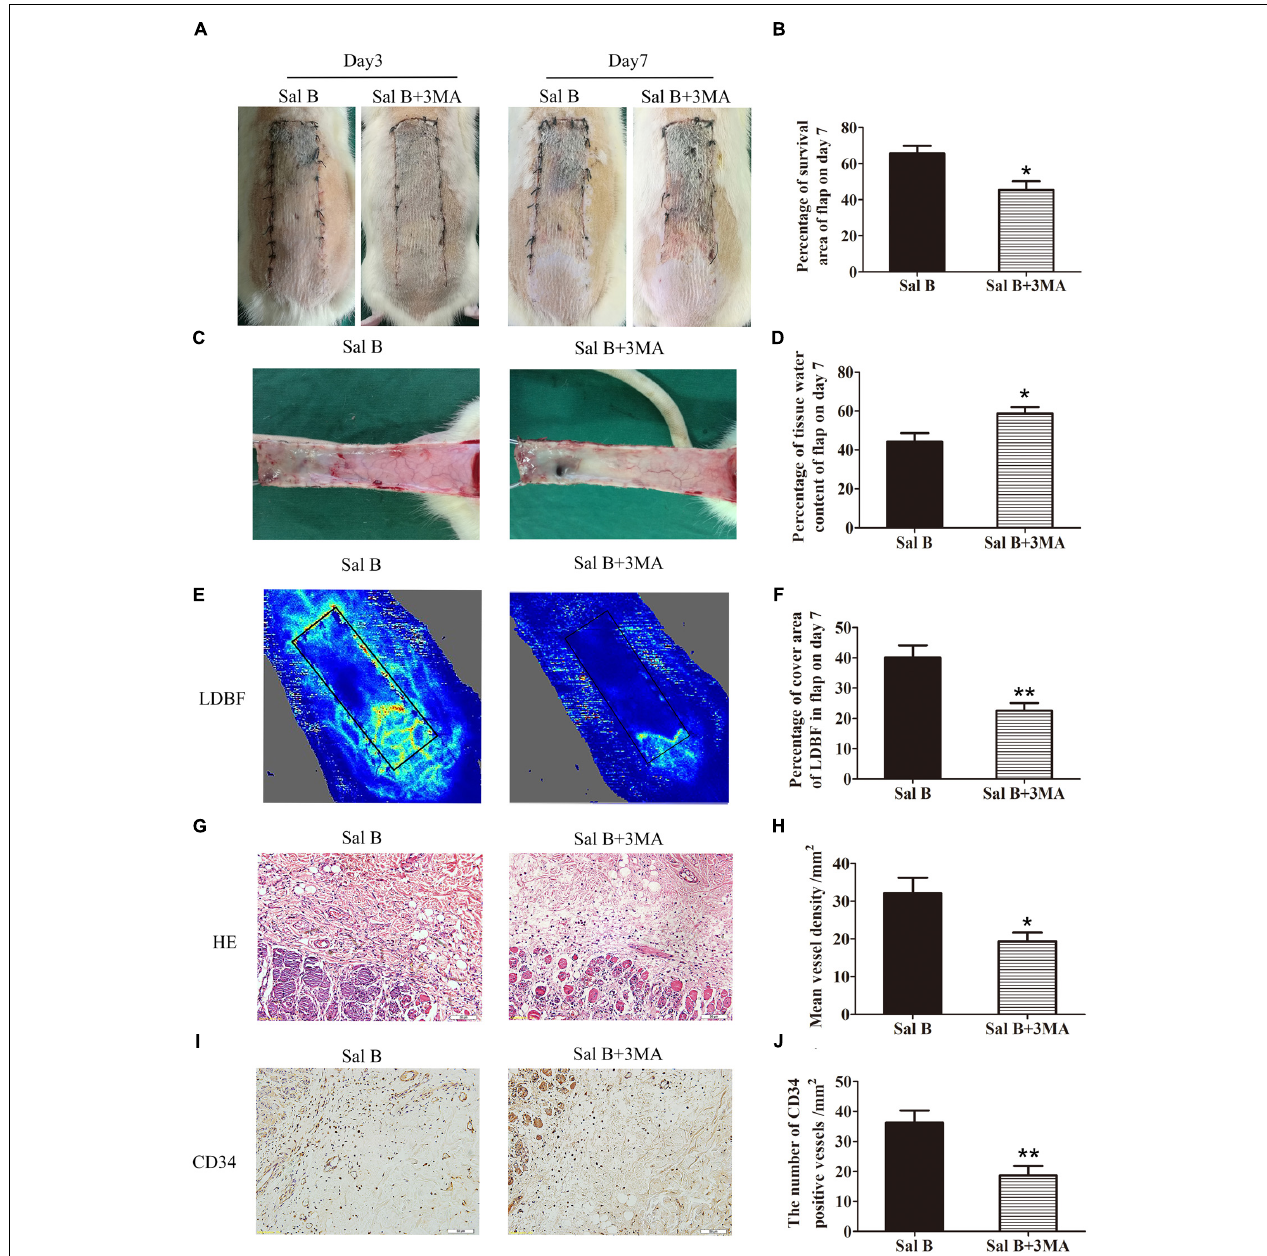
FIGURE 7 | Inhibition of autophagy reverses the effects of Sal B on flap vitality. (A) Digital photographs of flap survival of the Control and Sal B group on post-operative days 3 and 7 (scale bar: 2 cm). (B) Histogram of percentages of flap survival area on post-operative day 7. (C) Digital photographs of the inner side of skin flaps in each group on post-operative day 7 showing the degree of edema (scale bar: 2 cm). (D) Histogram of percentages of tissue water content of skin flaps. (E) LDBF imaging showing vascular flow and blood supply in skin flaps on post-operative day 7 (scale bar: 2 cm). (F) Histogram of percentages of area of blood supply. (G) H&E staining of microvessels in area II of skin flaps (original magnification: 200 × ; scale bar: 50 µ m). (H) Histogram of MVDs as determined by H&E staining. (I) IHC for CD34 in area II of skin flaps (original magnification: 200 × ; scale bar: 50 µ m). (J) Histogram of CD34-positive vessel densities. ∗ p < 0.05 and ∗∗ p < 0.01 vs. the control group. Data are means ± SEM ( n = 6 per